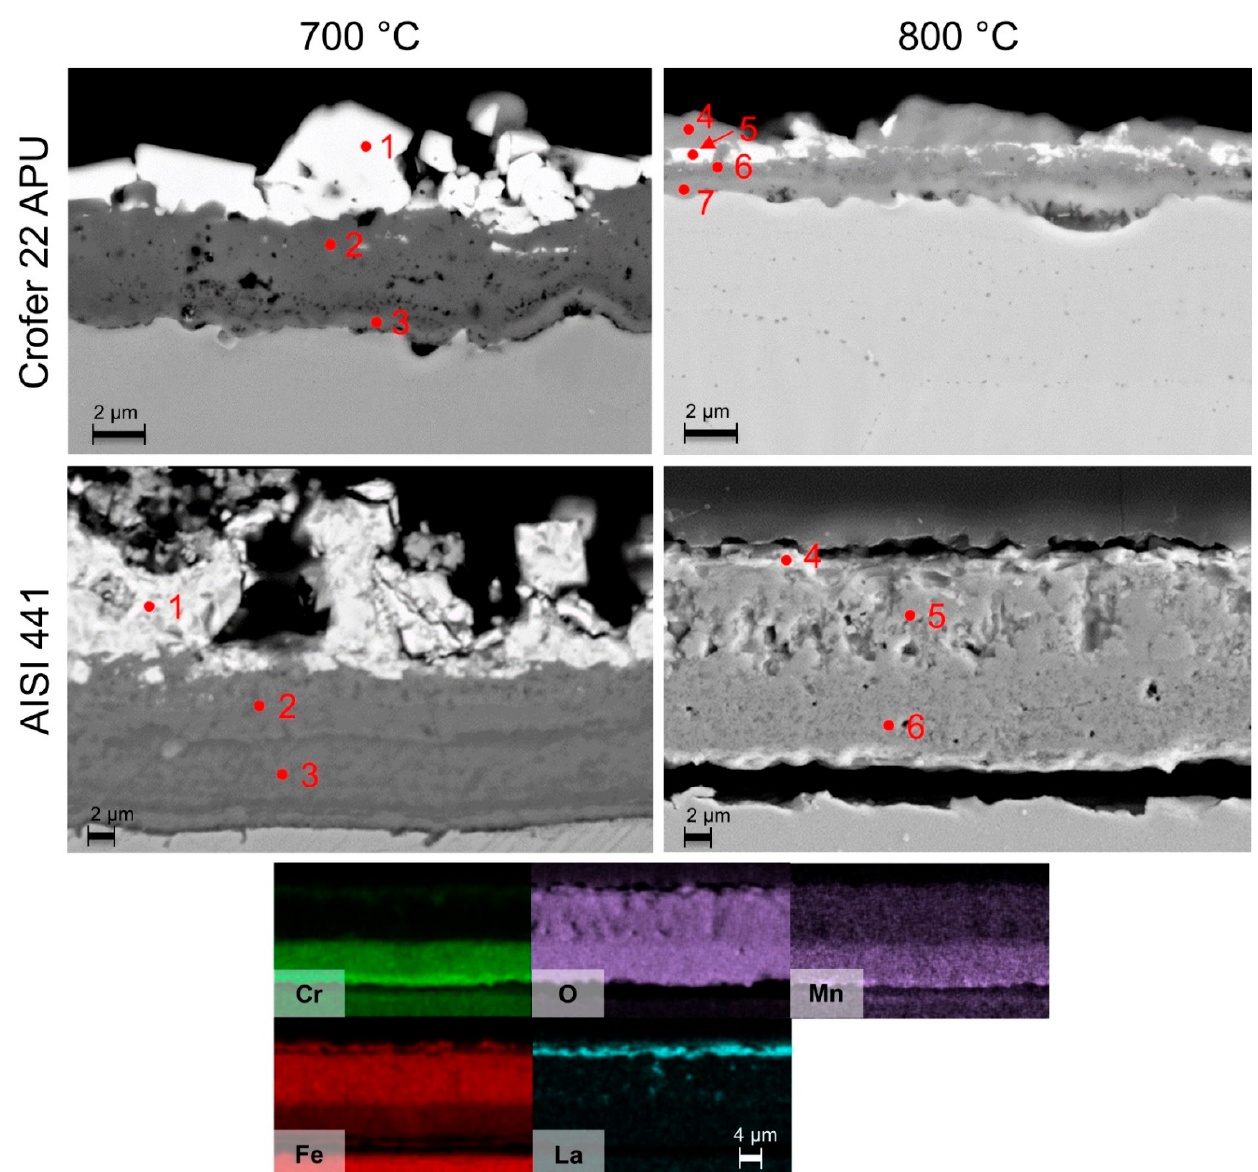
Figure 10. LFO coated Crofer 22 APU ( top , ×5000) and AISI 441 ( bottom , ×2500) after 1500 h at 700 °C ( left ) and at 800 °C ( right ) in oxidizing atmosphere. EDS point analysis was conducted from the spots indicated by red markers. The compositions in these spots are given in Table 6. For AISI 441 at 800 °C, EDS maps were also recorded as shown in this figure. Table 6. Element concentrations in wt./at.% measured with EDS analysis from LFO coated Crofer 22 APU and AISI 441 after 1500 h at 700 °C and 800 °C. The location of the spots is marked in Figure 10.